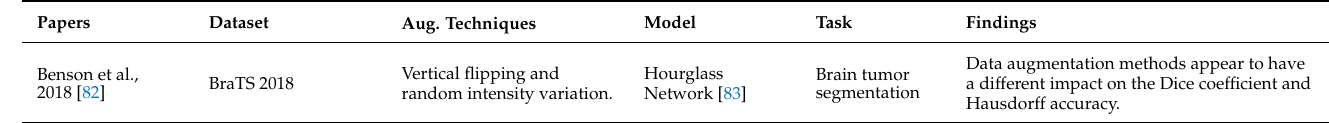
Table 2. Survey of data augmentation techniques in recent image segmentation